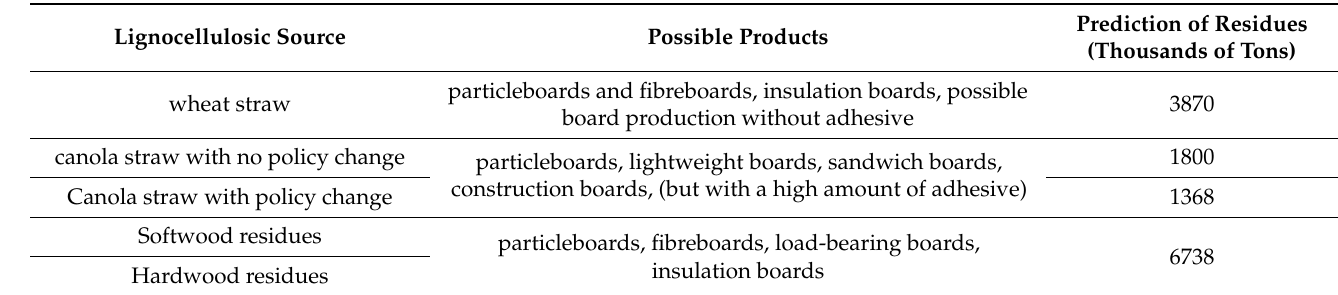
Table 3. Prediction of material quantities in